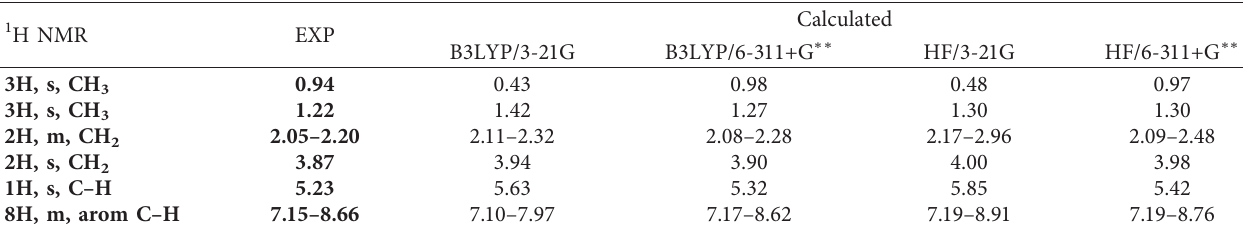
Table 7: Experimentally measured and calculated 1 H chemical shifts δ (ppm vs TMS) of the compound (5b) . 1 H NMR